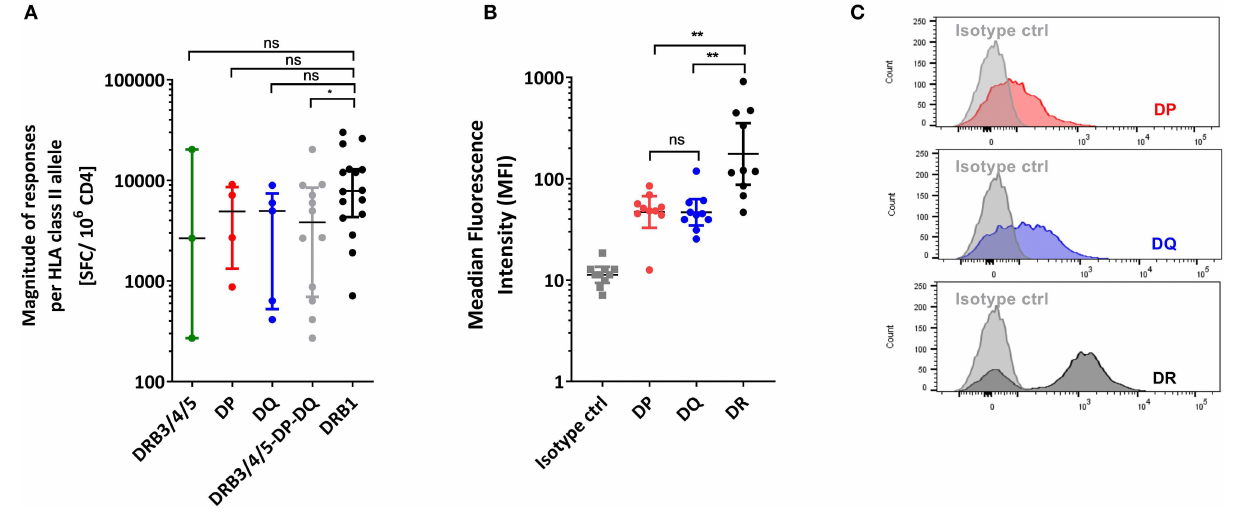
shared with DRB1 (17%), two with DRB3/4/5 (8%), and three with DP